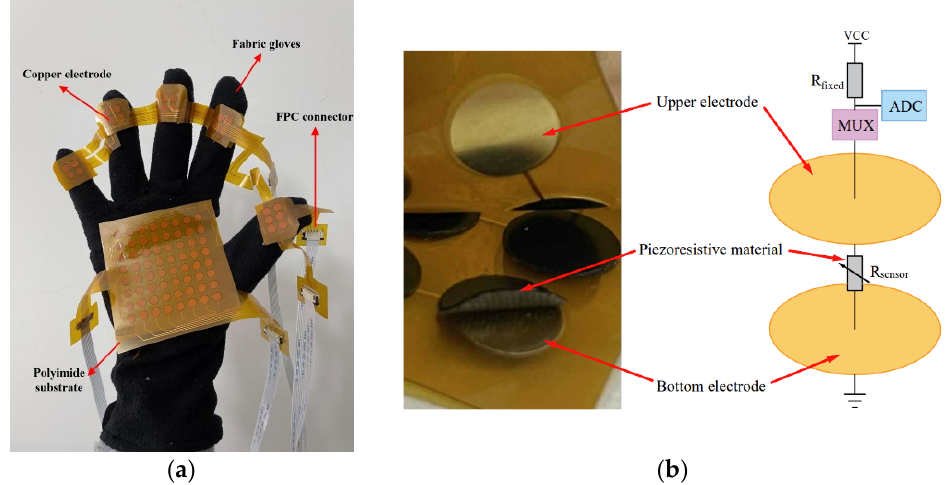
Figure 1. Physical diagram and schematic diagram of the tactile sensor. ( a ) Physical image of the tactile sensor integrated into the glove; ( b ) Schematic of the tactile sensor.